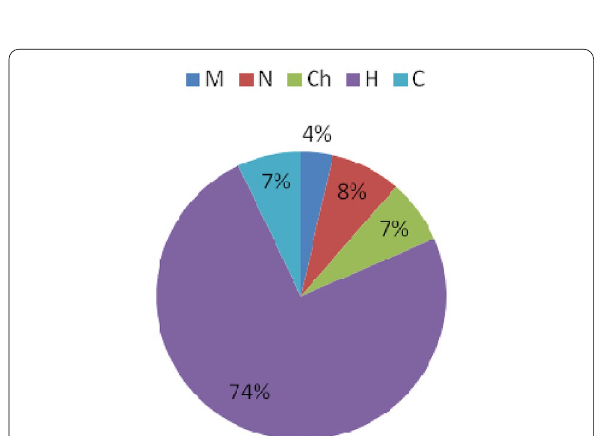
Fig. 11 Composition of the life forms in the flora R. rosea habitats (Raunkiaer 1934): M, Mesophanerophytes; N, Nanophanerophytes; Ch, Chamaephyts; H, Hemicryptophytes; C,